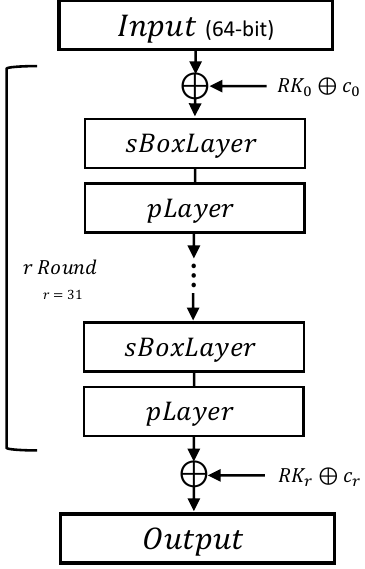
Figure 1. PRESENT